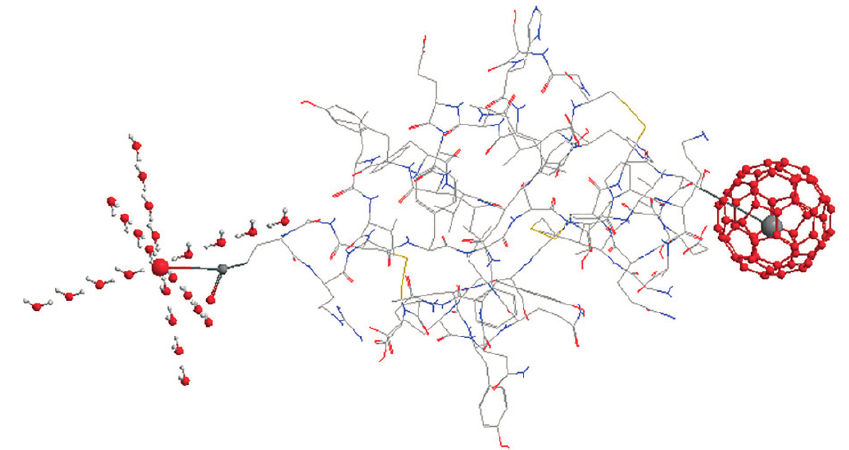
Figure 8. Schematic of two structural motifs of water cluster around polar and non-polar group of insulin molecule. Most of the insulin molecule is displayed in wire frame except for one carboxylate (above left) and one methyl (above right) shown in ball and stick mode. The magnified oxygen atom of carboxylate is surrounded by CS-like water cluster. The magnified methyl is surrounded by ES-like cluster of 60 water